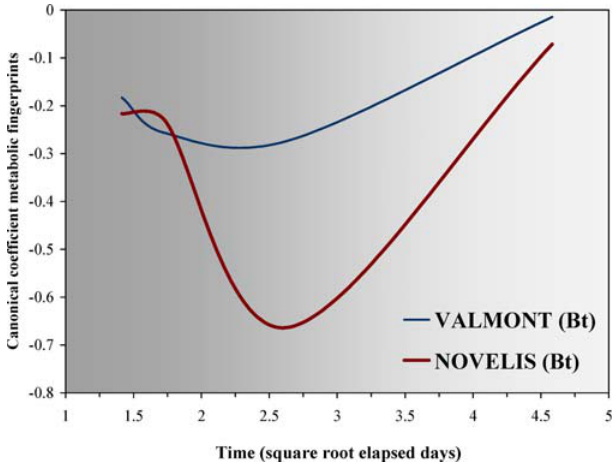
Figure 4. Multivariate Analysis of the Soils Amended with Transgenic Maize PRCs of the summarized metabolic fingerprints of the two Bt -maize straws (both Nobilis and Prelude as conventional isoline control level as horizontal x -axis) according to all BIOLOG EcoPlate carbon sources ( n ¼ 3 in duplicate). Day 3 is the most significant by time for all maize